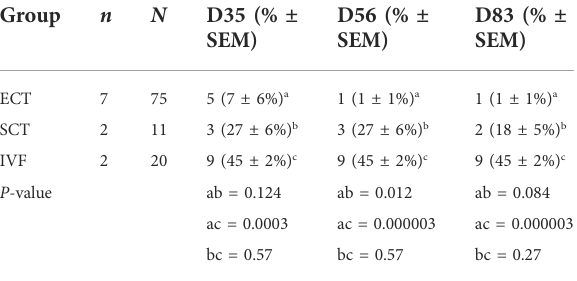
Embryoswerecloned fromnocodazole-arrested, mitoticICM-derivedprimary cultures (ECT), serum-starved, quiescent adult ear skin fi broblasts (SCT) or in vitro fertilized controls (IVF). n = number of independent experiments; N = number of blastocysts transferred into surrogate dams; a,b,c = groups with these superscripts within a column differ by the indicated p -value, as determined by the Fisher exact test in 2 × 2